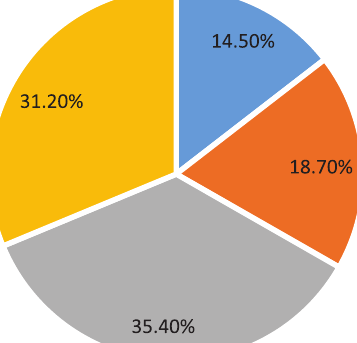
Figure 2. Respondents’ attitudes related to confirmation bias statements. Notes: Blue stands for the statement “if you see a political news that your friend shared in social media you would probably like it and think is relevant”; orange for “if you see political news shared by a friend in social media, you would probably like it, comment, and share”; grey for “if you encounter news in social media that has a positive context for your affiliated political party, you would probably like it” is in grey; and yellow for “if you encounter news in social media that has a negative context for your affiliated political party, you would probably ignore